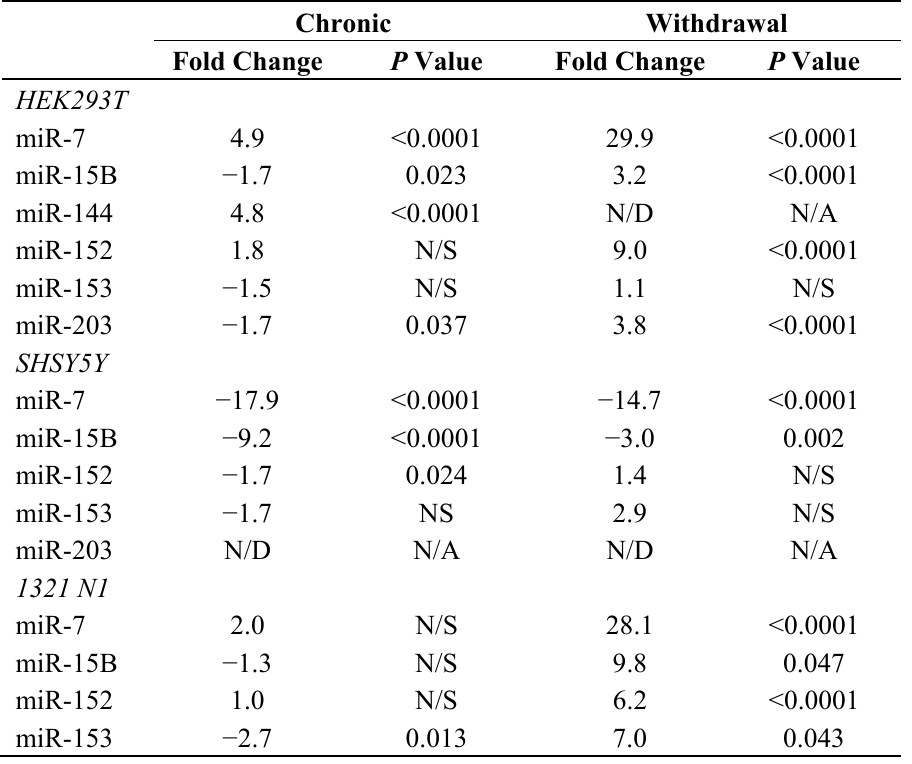
Table 1. Fold Change in expression of miRNAs following chronic ethanol treatment and